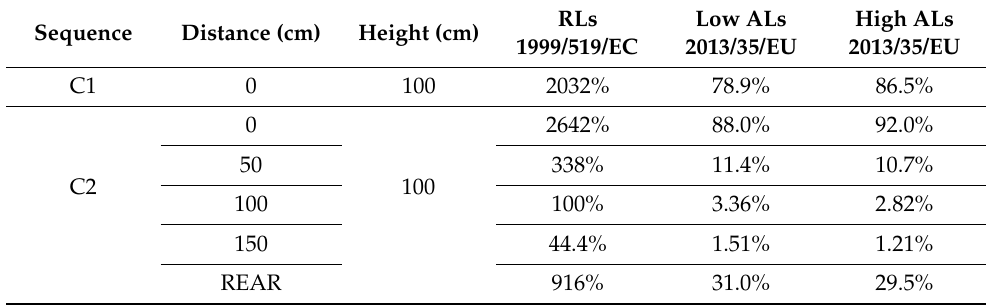
Table 8. Measurement results with the EHP-50F probe (WP mode, magnetic field, full scale 100 µ